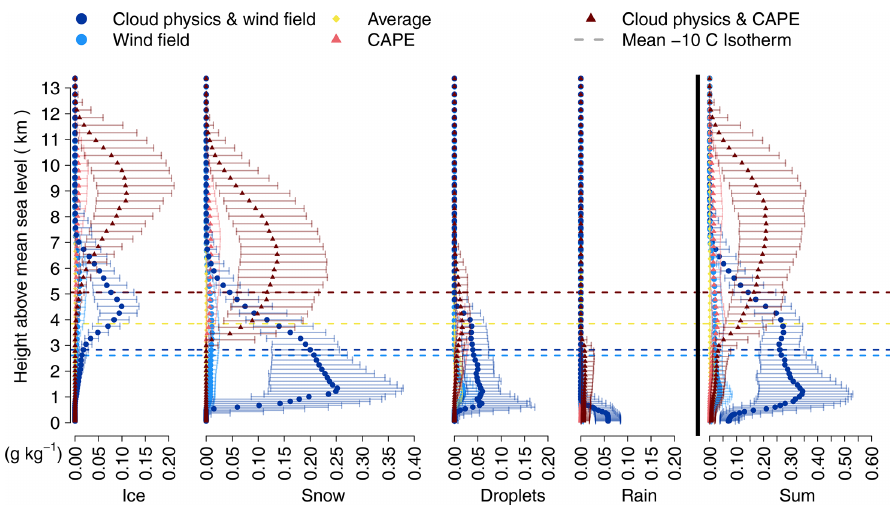
Figure 6. Clusterwise medians along with upper and lower quartiles of suspended particles (ice crystals and droplets) and hydrometeors (snow and rain) at each model level in ERA5 plotted at the mean model level height of the respective clusters. For each cluster the mean height of the − 10 ◦ C isotherm is included as a dotted line. The last panel displays the sum of the other four and uses a different scale.